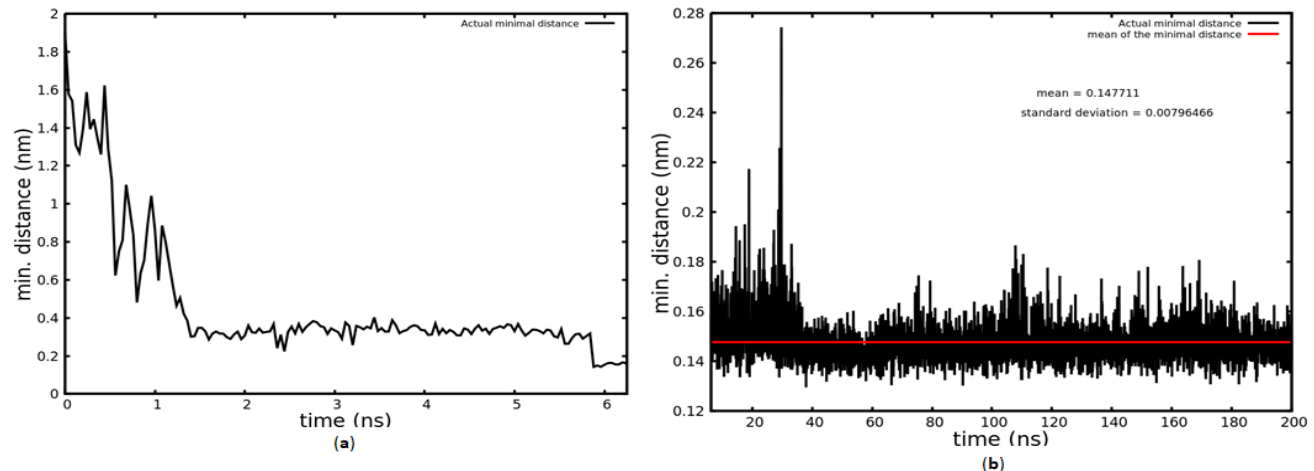
Figure 1. The distance between the TiO 2 surface and the nearest peptide atom over time. In ( a ), the first 6.25 ns is shown; in ( b ), the last 193.75 ns is shown.